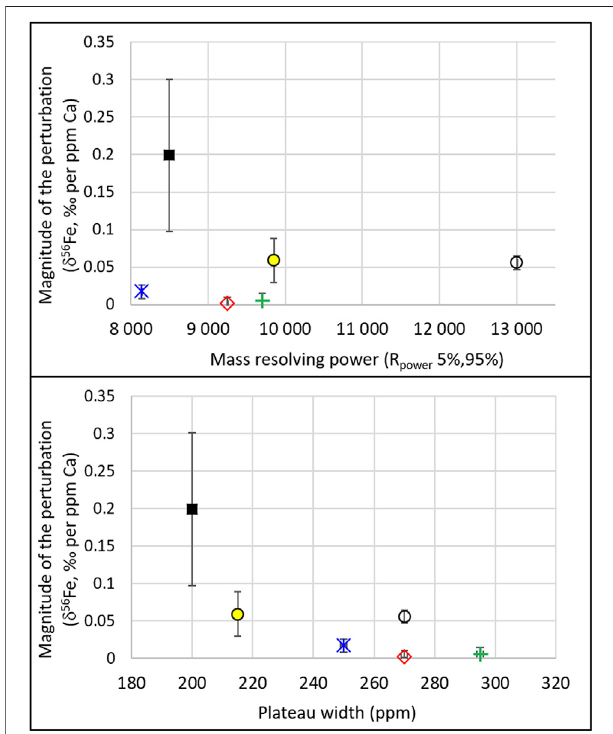
FIGURE 6 | For the six different settings presented in Figure 5 (variable resolutions and plateau widths), and for the maximum Ca concentration tested in each of these settings (3 ppm for the 2015 and 2016 tests and 10 ppm for the 2017 and 2018 tests), the magnitude of the perturbation (i.e., the absolute value of the difference between the measured and the expectedvalues)normalized totheCaconcentrationisshownasafunctionof the mass resolving power (top) and plateau width (bottom) . Error bars show the uncertainties propagated from those shown (and described) in Figure 5 . The Neptune Plus data are represented by the open black